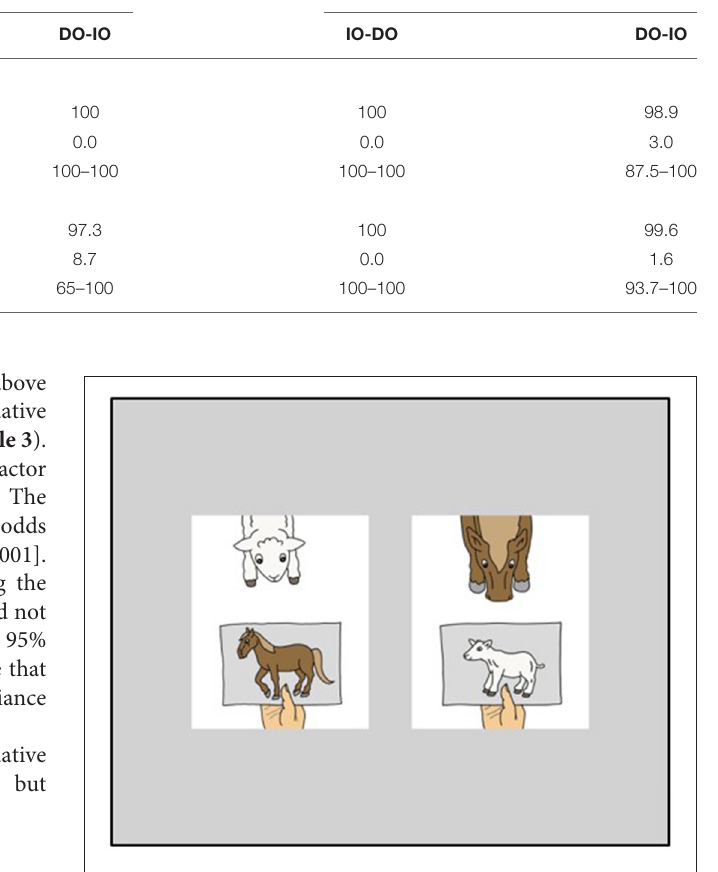
FIGURE 1 | Item example as presented during the sentence-picture matching task “ich gebe dem lamm sicherlich das pferd” (“certainly, i give the horse to the